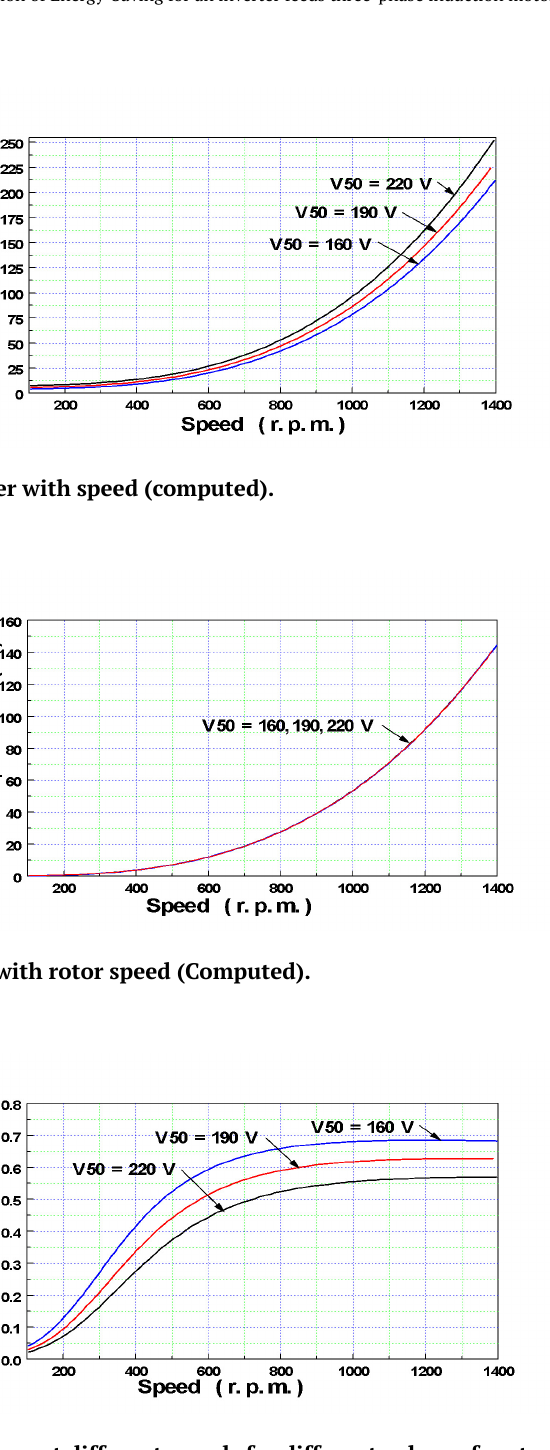
Fig. 8. The values of motor efficiency at different speeds for different values of motor voltages (Computed). Experimental results proved the simulation results pre- sented in the